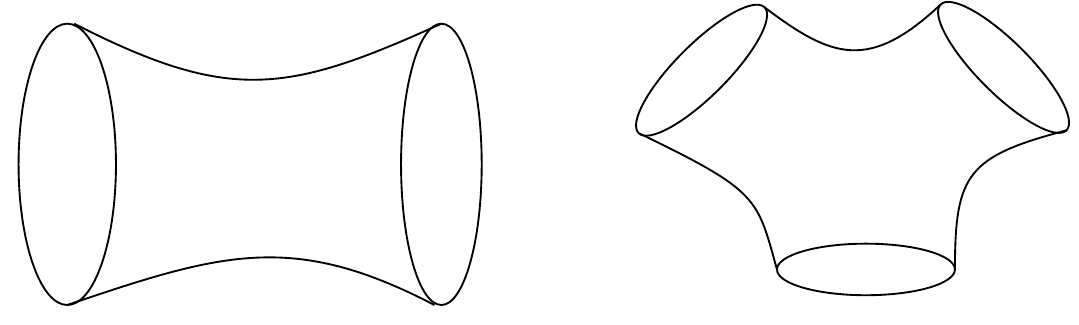
Figure 15 . Two- and three-boundary geometries with